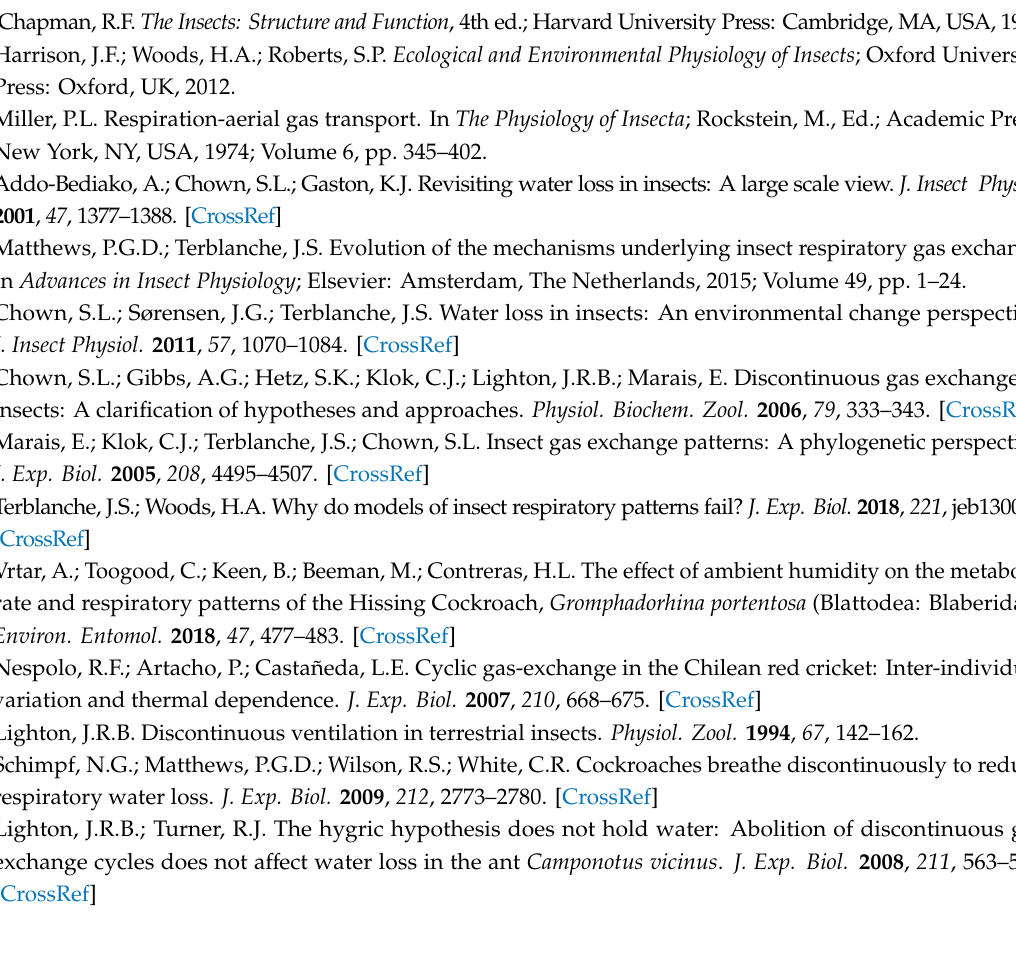
species showing CGE and DGE from literature (8) and Nauphoeta cinerea from this study used for regression comparison of metabolic cost between CGE and DGE species shown in Figure 3a (columns shaded grey were used for regression relationships), Table S4: Body mass and metabolic rate (both measured and Q 10 corrected to 23 ◦ C using a Q 10 of 2) of tenebrionid species showing CGE and DGE from literature (23) and Zophobas morio from this study used for regression comparison of metabolic cost between CGE and DGE species shown in Figure 3b (columns shaded grey were used for regression relationship), Table S5: Data for 30 insect species from Woods and Smith (2010) for the regression relationship of respiratory water cost of gas exchange, and the two species from our study were superimposed to the regression relationship (given at the end of the table),); 95% confidence and prediction intervals were calculated for the overall regression (Figure 4b). Shaded columns were used for regression